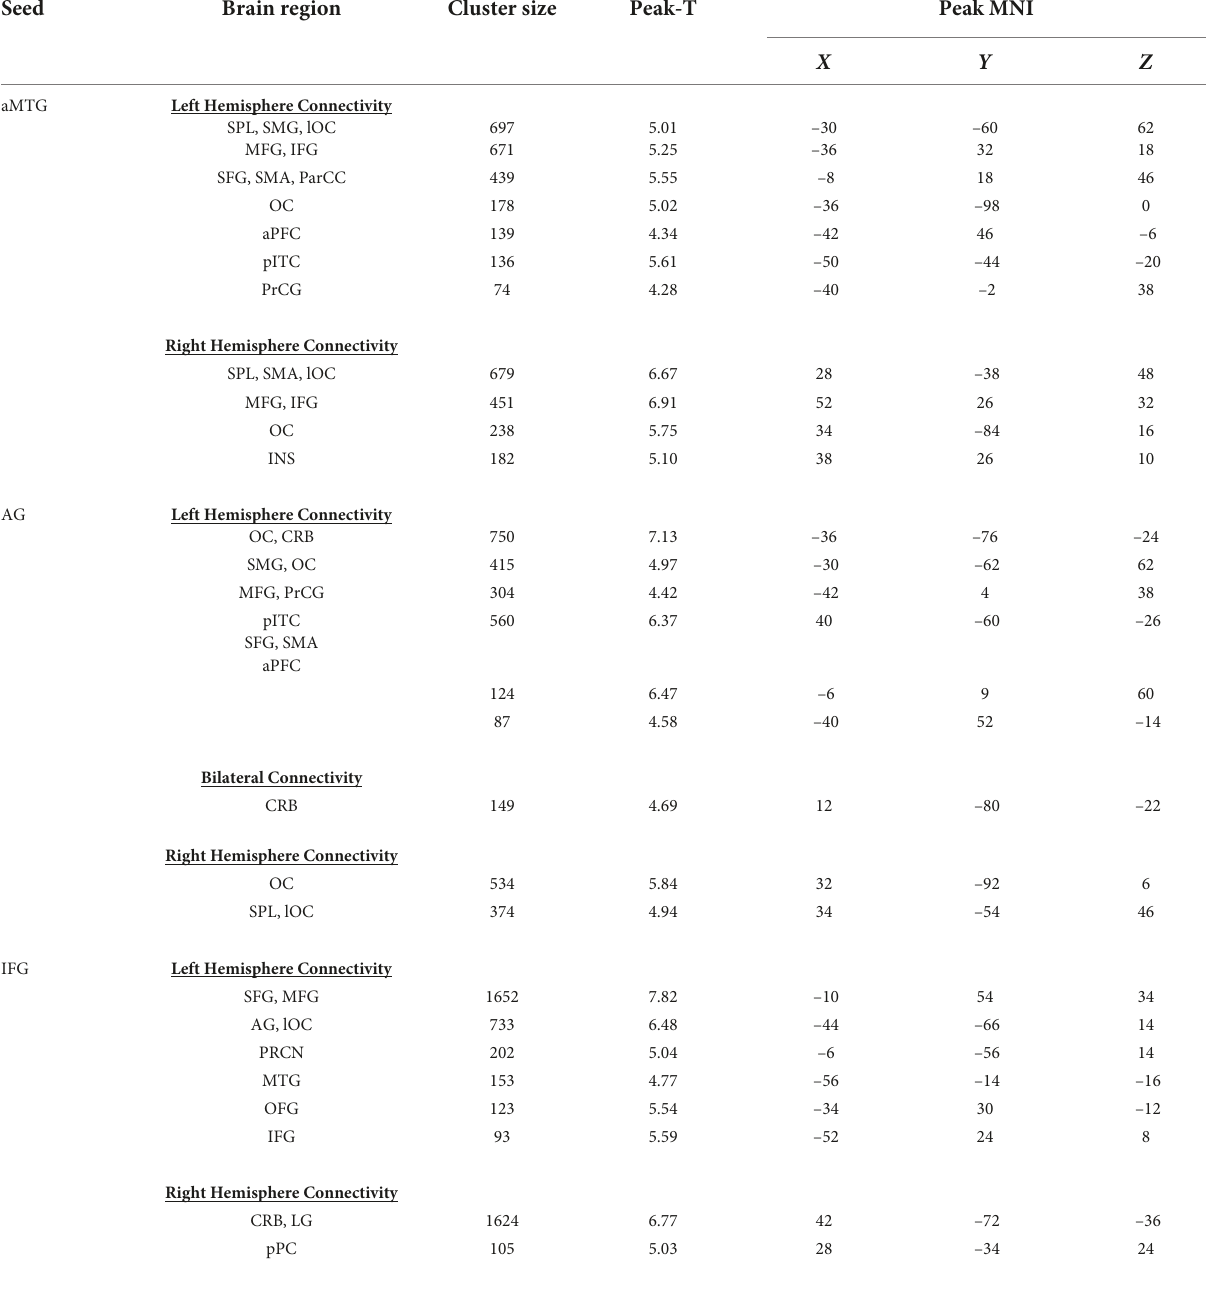
TABLE 3 Seed-to-voxel analyses for concrete word relative to rhyme processing.